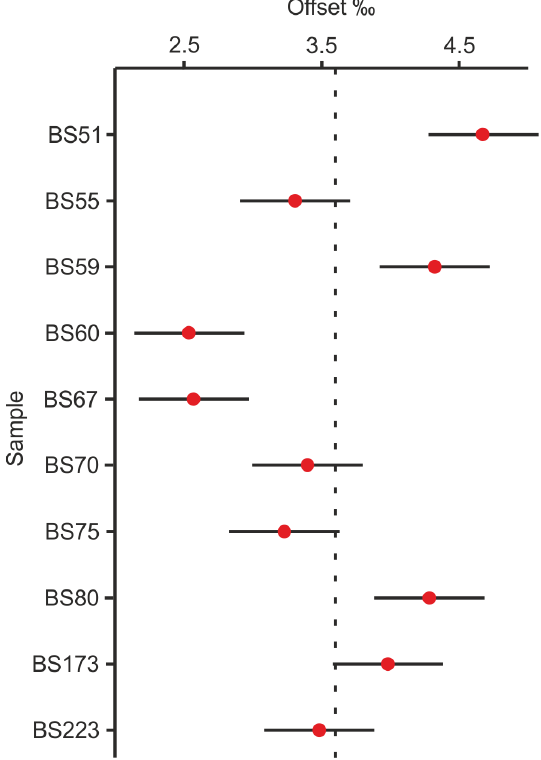
Figure 4. The offset between δ 18 O diatom (from the 3–15µm frac- tion) and δ 18 O ∗ sponge (mass balanced value for the > 38µm frac- tion). The horizontal error bars for each point represent the ± 0.4‰ analytical reproducibility. The mean offset (3.0‰) is shown by the dashed